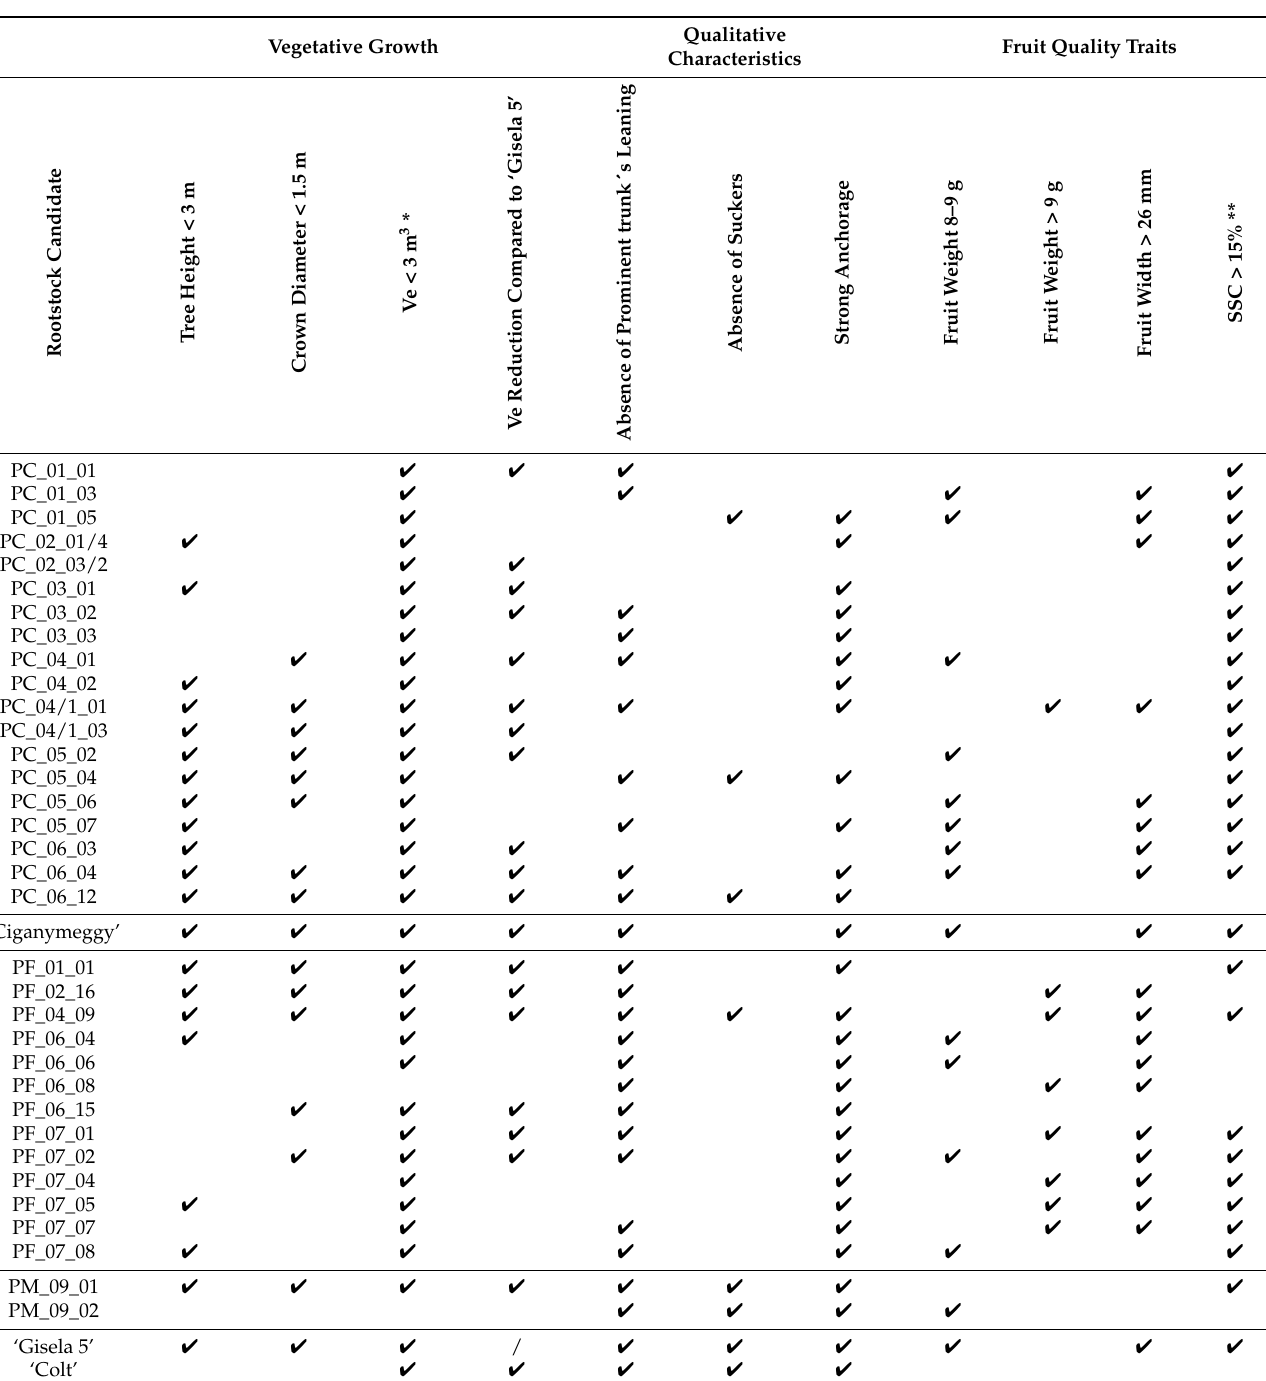
Table 3. The rootstock candidates’ assessment based on grafted ‘Summit’ trees’ vegetative, qualitative and generative characteristics in the fifth year after plantation establishment. Qualitative Vegetative Growth Fruit Quality Characteristics